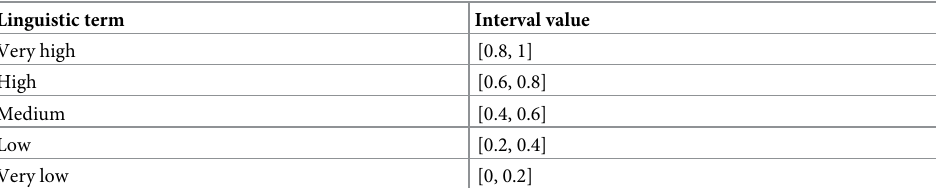
Table 1. Linguistic terms used in this